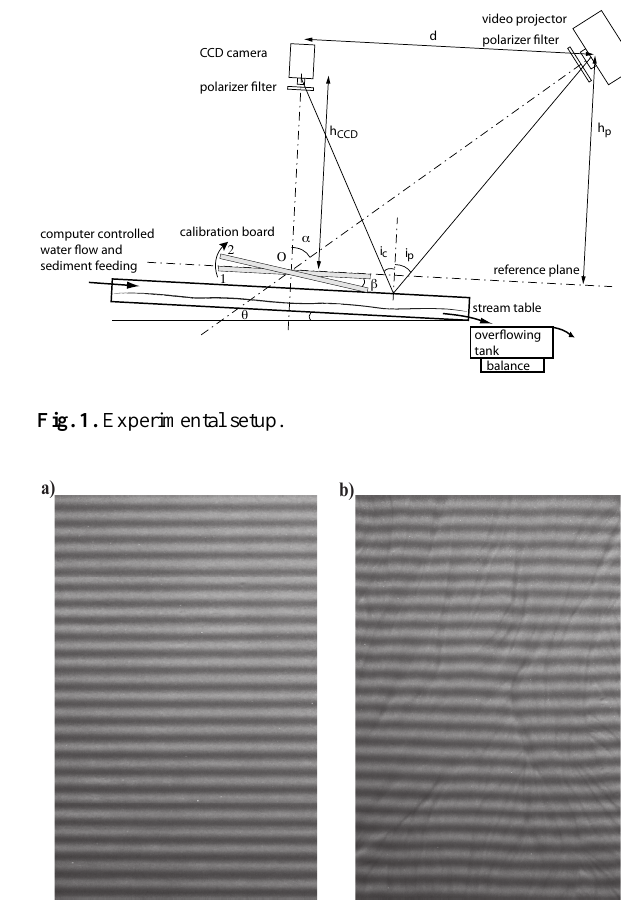
Fig. 2. Fringe pattern on (a) flat surface, (b)